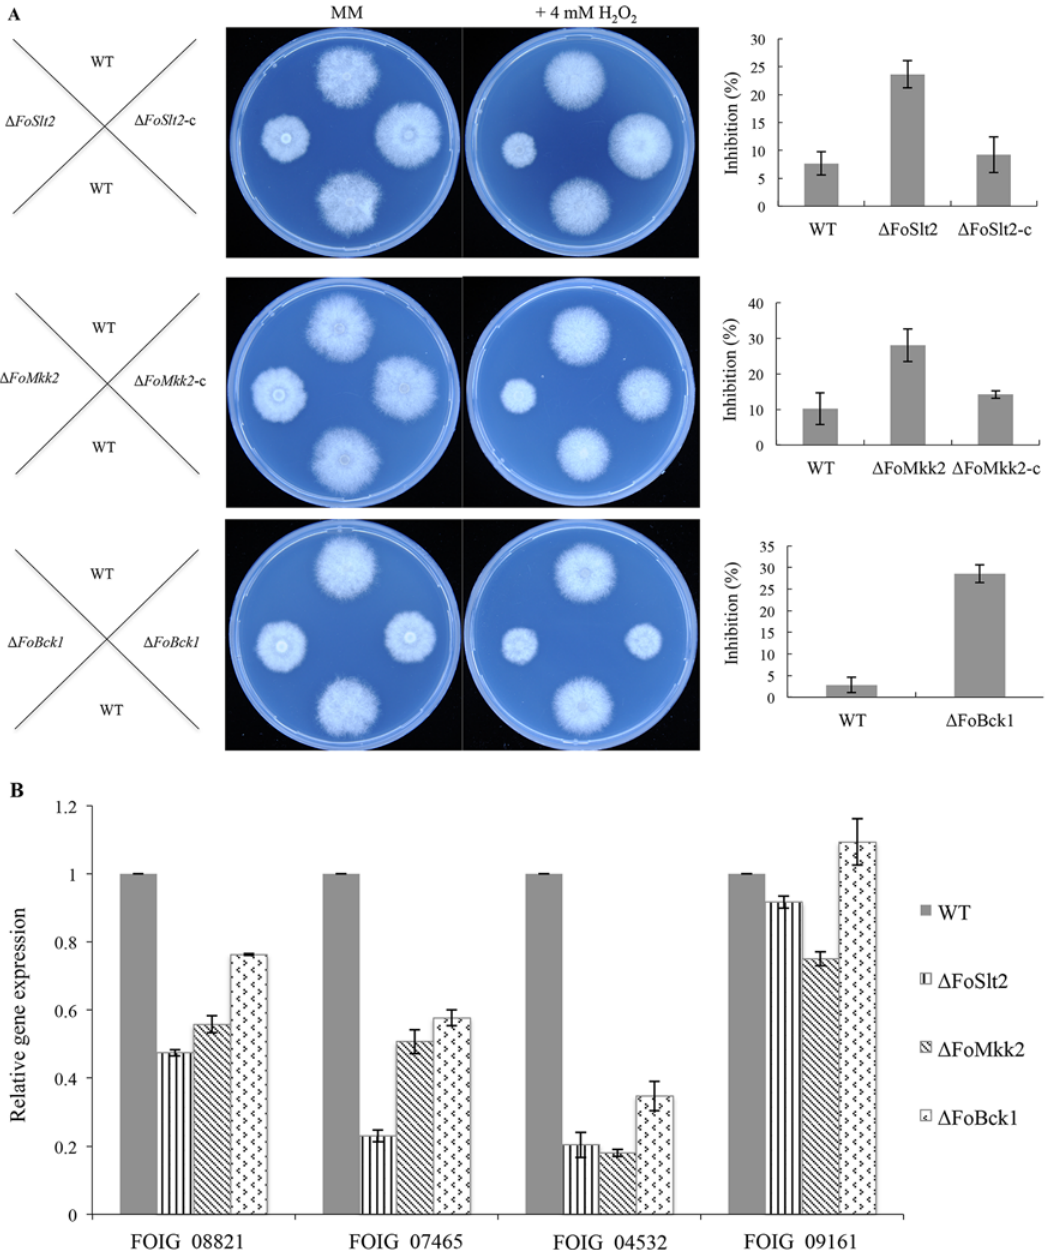
Fig 4. The deletion mutants were sensitive to H 2 O 2 . (A) Middle panels of figures show colony morphology of the WT, mutants Δ FoSlt2 , Δ FoMkk2 and Δ FoBck1 , complemented strains Δ FoSlt2 -c and Δ FoMkk2 -c were incubated on MM plates supplemented with 4 mM H of figures show inhibition of the radiated growth of the indicated strains grown on the MM plates with the same order as the middle figures. (B) Quantitative real-time PCR analysis of peroxidase synthase genes in the WT, mutants Δ FoSlt2 , Δ FoMkk2 and Δ FoBck1 . The four peroxidase synthase genes are FOIG_08821, FOIG_07465, FOIG_04532 and FOIG_09161. Error bars indicate the standard error from three replicates.